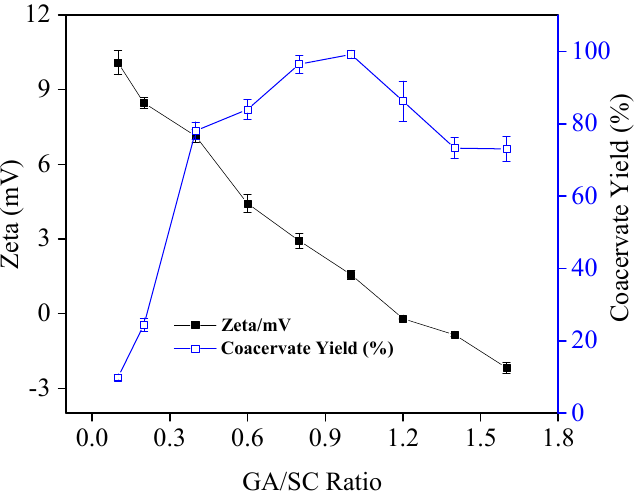
Figure 4. Coacervation of SC and GA as a function of mixing ratio. Zeta potential of the OMC microcapsules were recorded by dynamic light scattering (DLS) with a Zetasizer Nano ZS (Malvern Instruments, Worcestershire, UK). Means of values obtained in triplicate ( p < 0.05). Table 3. Zeta-potential, size, and PDI of particles with different samples ratio of GA and SC.